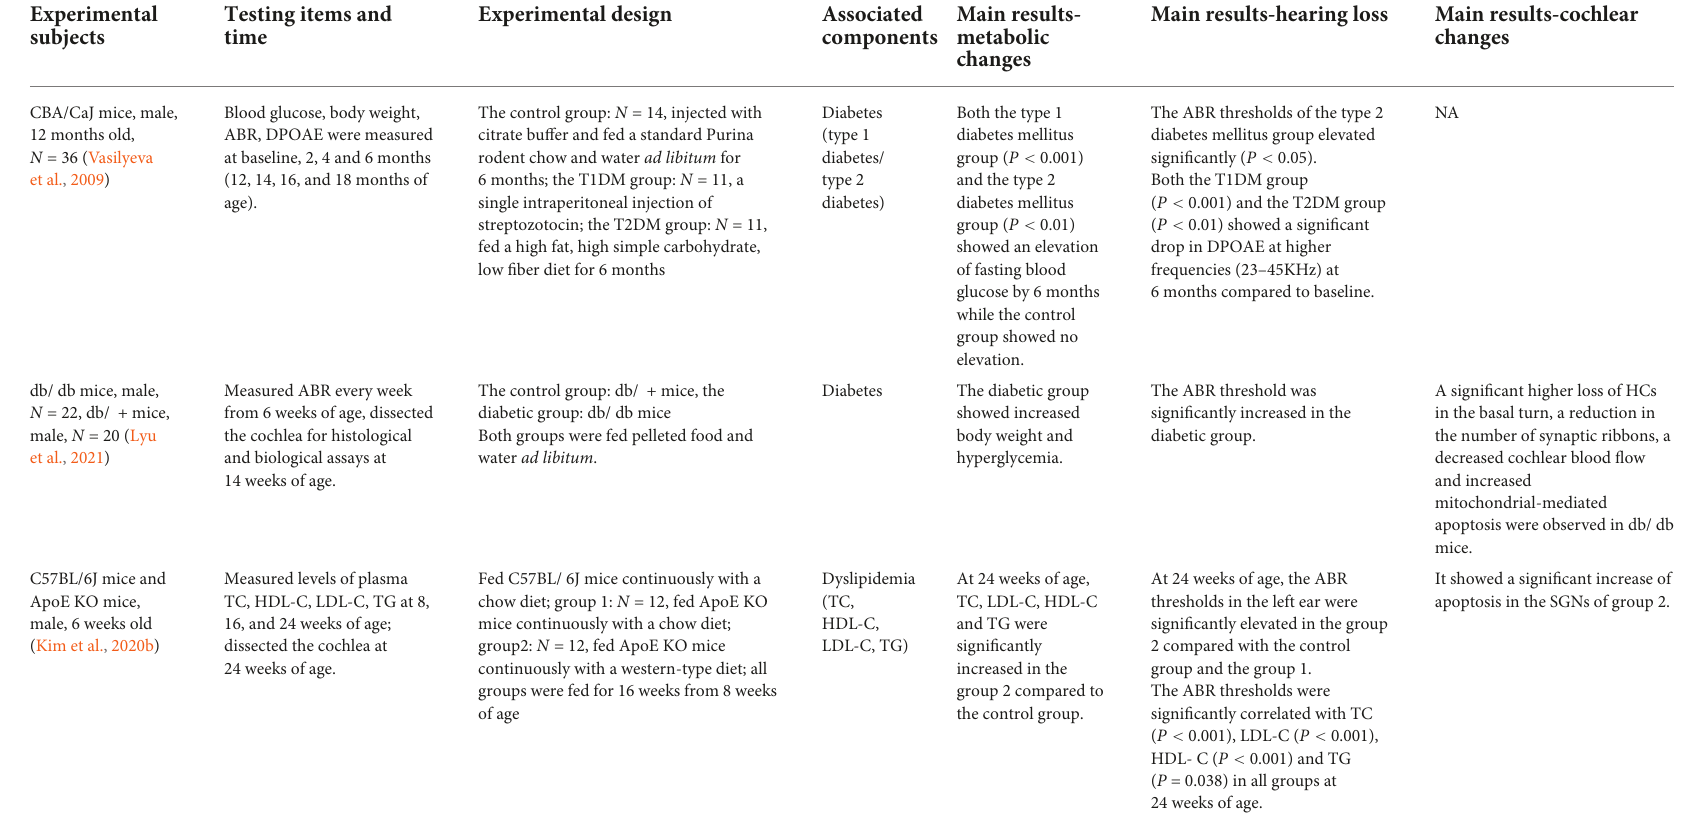
TABLE 2 Main animal studies about the relationship between metabolic syndrome (MetS)/its components and hearing loss [mainly age-related hearing loss